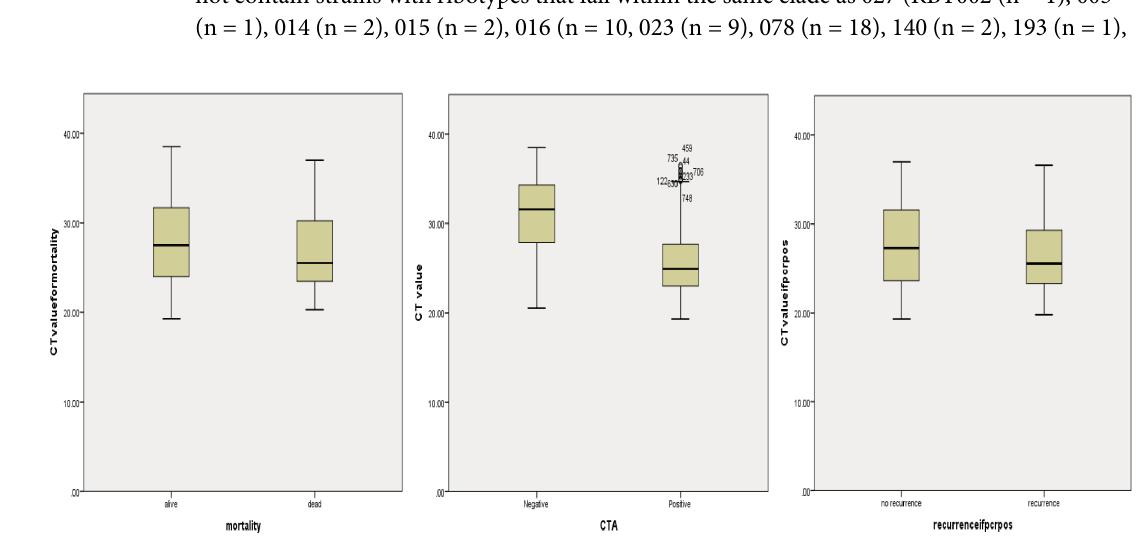
PLOS ONE | https://doi.org/10.1371/journal.pone.0205941 December5,